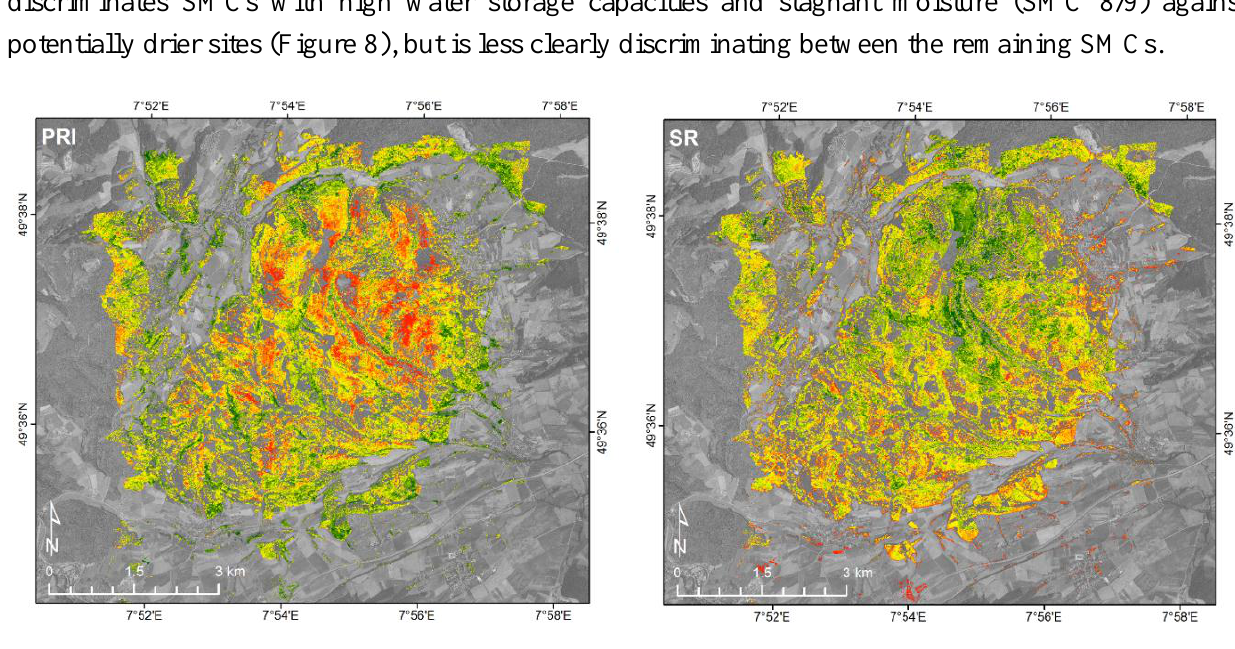
Figure 10. Spatial pattern of PRIn ( left ) and SRn ( right ) produced with the HySpex2.5 data set. All maps are colored from red (mean – 2 standard deviations) to green (mean + 2 standard